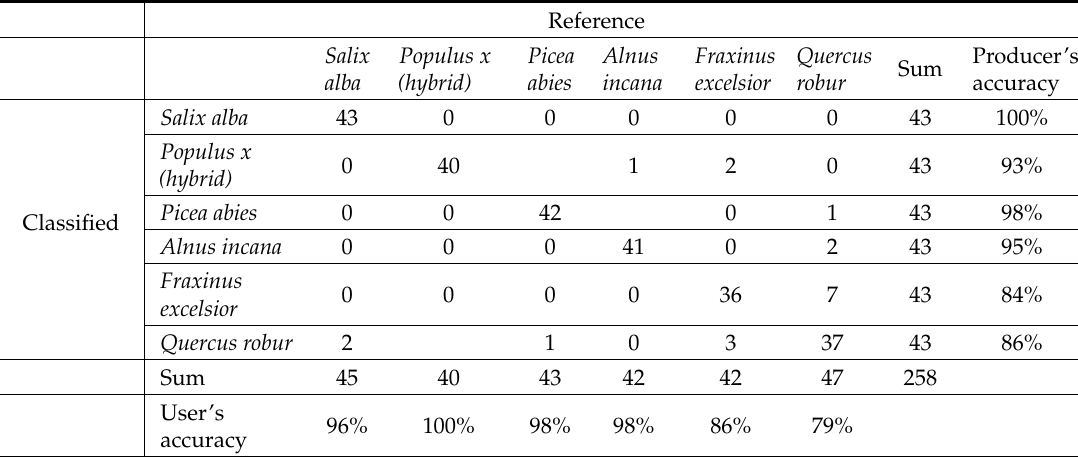
Table A3. The accuracy assessment using the PCA data cube (with 20 components) as an input to the RF